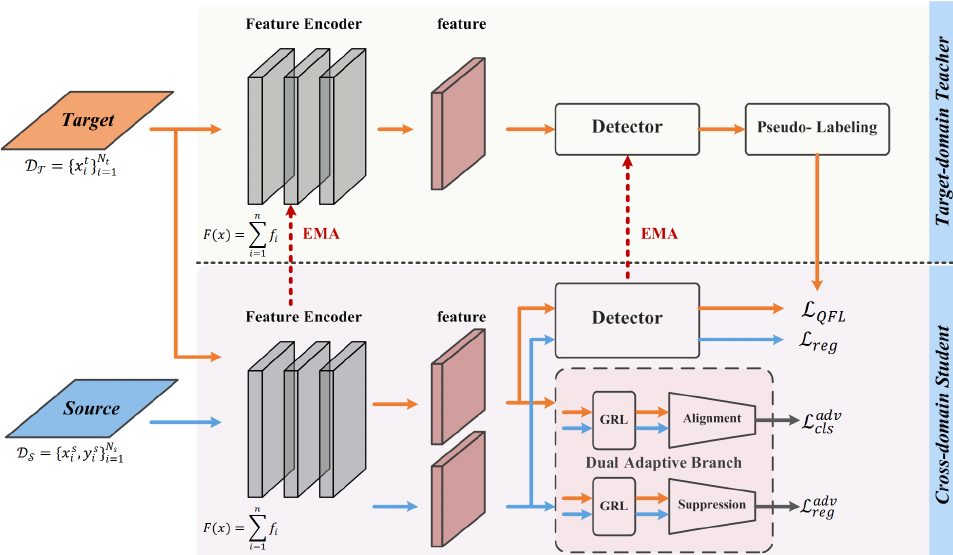
Figure 2. Framework Overview. This framework consists of two parts: a target-domain teacher model and a cross-domain student model. In target-domain teacher model, the target domain images are feeding into the teacher model to generate pseudo-labels. In cross-domain student model, we propose a DAB structure. With the purpose of feature alignment branch, the features are mappes into a high-dimensional space, and they restrict the gradient using a distribution difference measure function, which minimizes the difference of domain-invariant features between two domains. With the purpose of feature suppression branch, the domain-specific features are constrainted, which eliminate the influence of domain-specific feature on cross-domain object